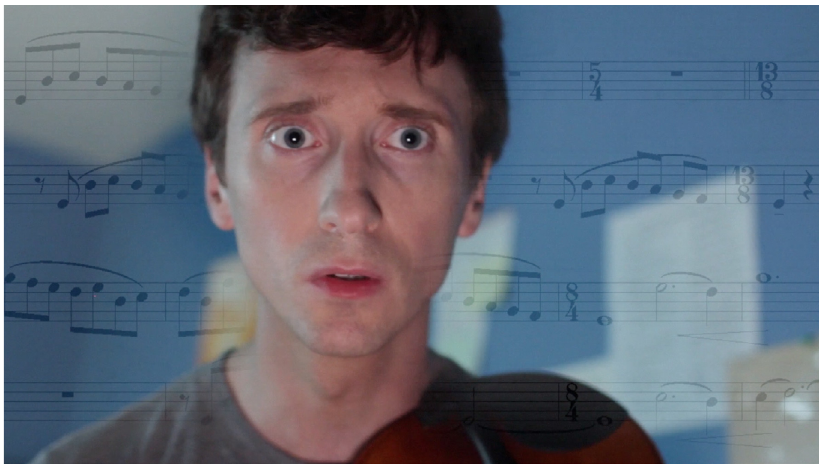
Fig. 2 – Michael Roth, The Web Opera , still photo from episode